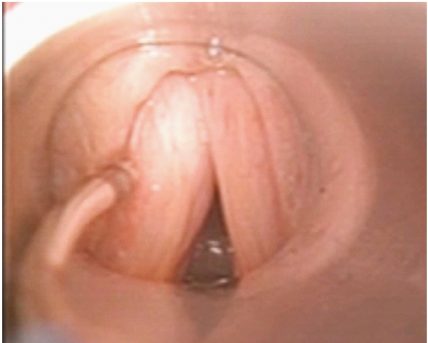
Figure 1: Endoscopic captures of the vocal folds in the patient FS4 (group I) before, during, and after injection (pictures captured from endoscopic